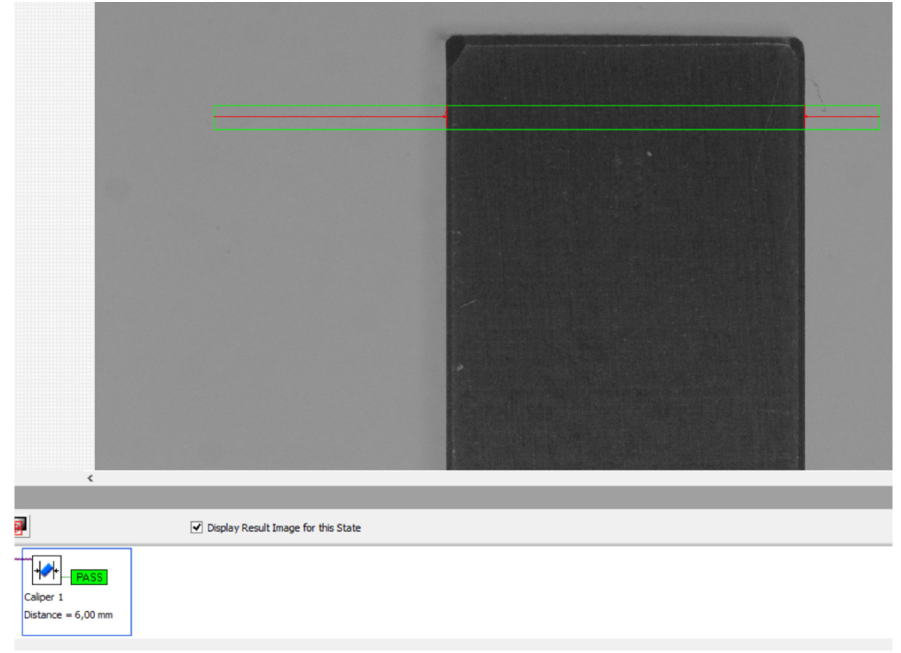
Figure 5. Validation of RMS measuring procedure with measuring standard of 6.00mm.